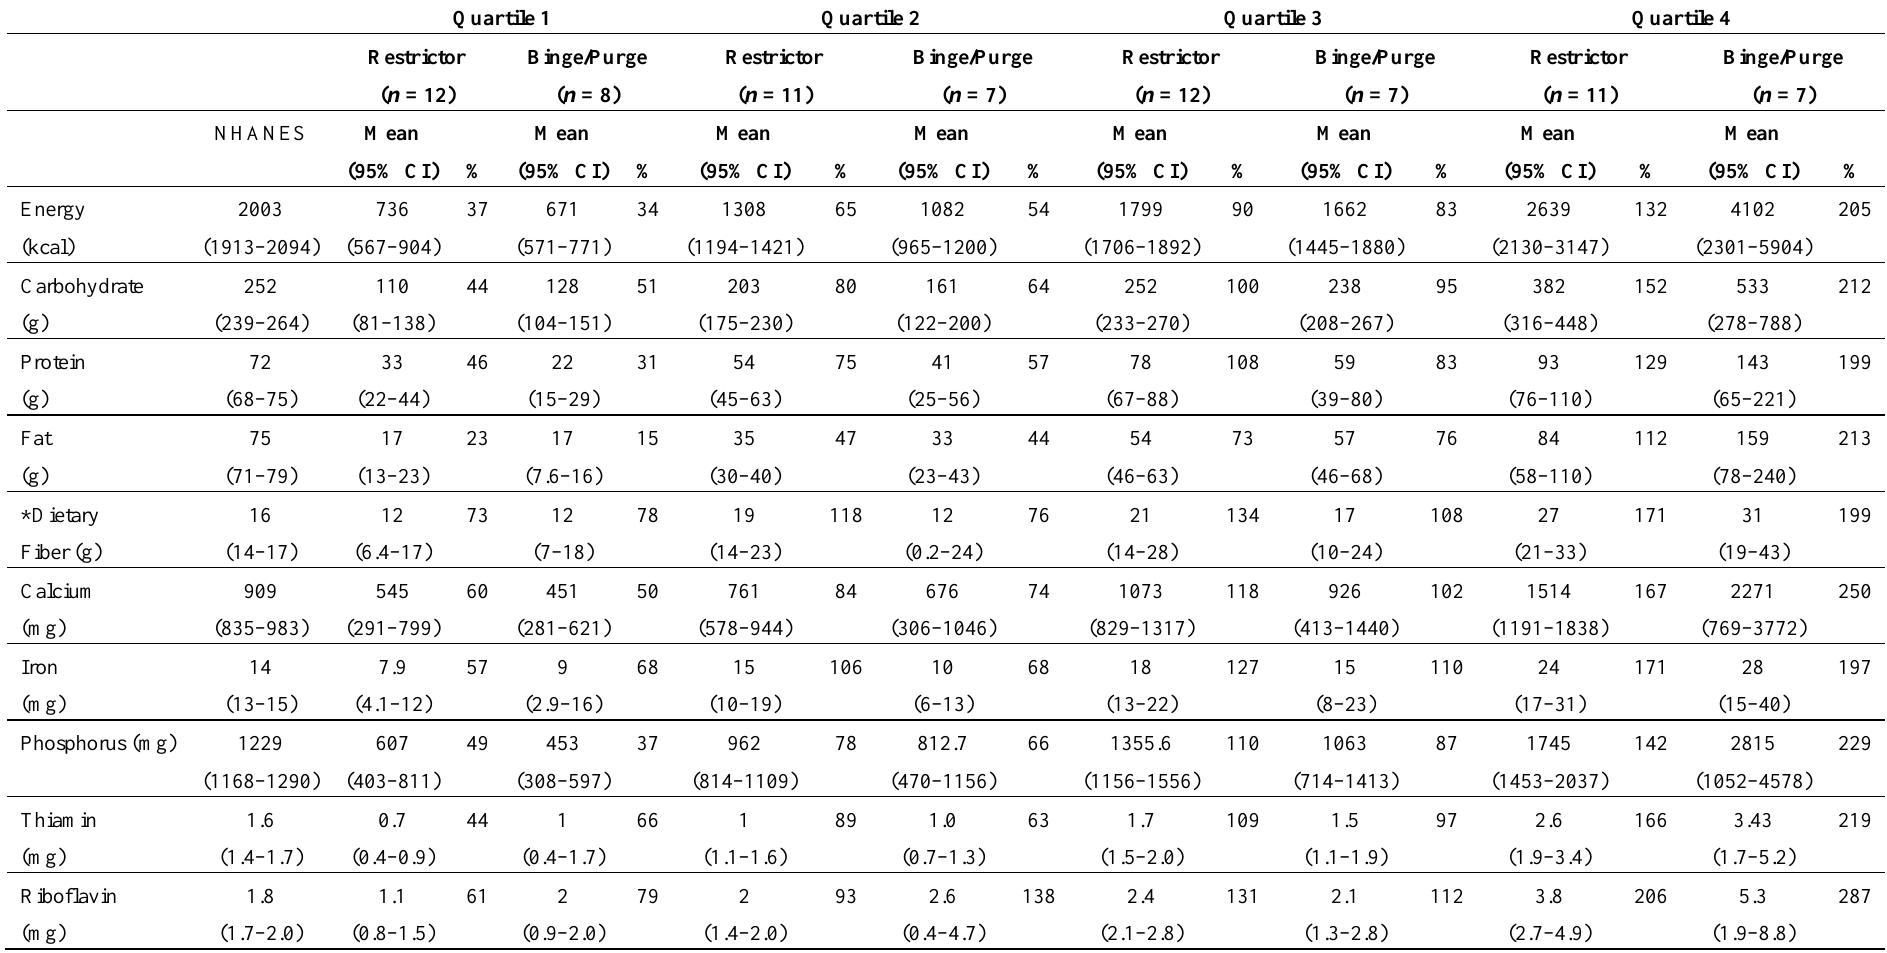
Table 2. Reported dietary intake of individuals with anorexia nervosa (by subtype and quartile) and comparison (%) to a representative